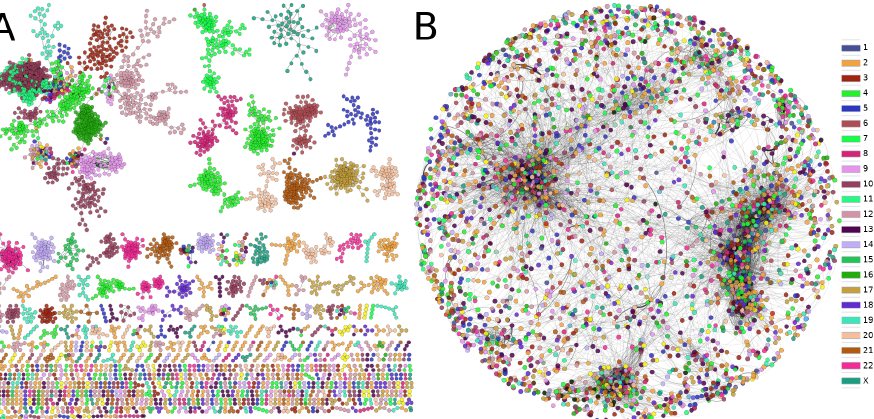
Figure 7. Comparison between ( A ) gene and ( B ) protein co-expression networks. The color of nodes represents the chromosome to which each gene belongs. The loss of inter-chromosome interactions in ( A ) contrasts with the diversity of edges in the PCN. Additionally, the size of the largest component in both cases is largely